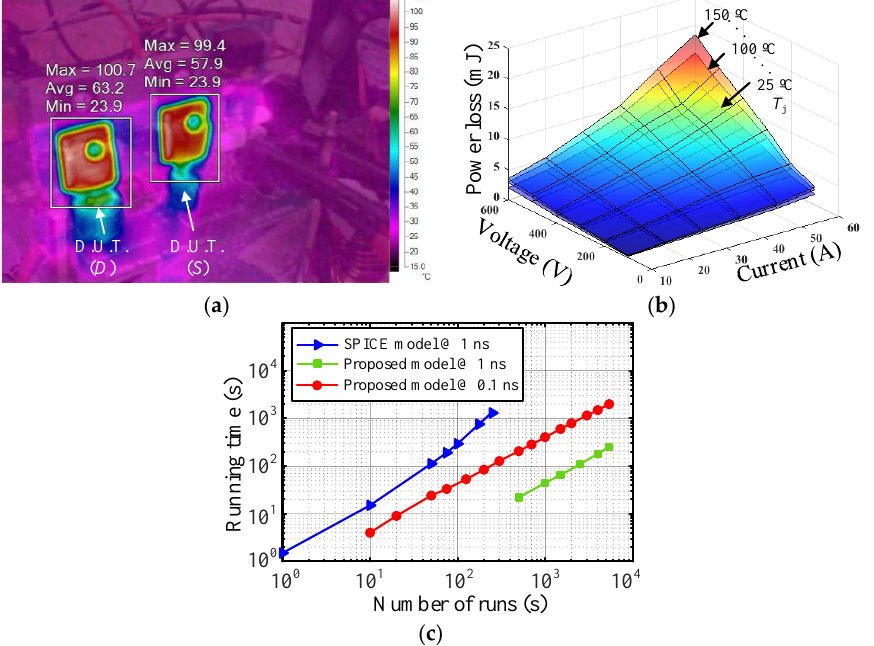
Figure 19. DPT results of ( a ) thermal image; ( b ) loss LUT for Si IGBT; ( c ) time cost comparison.